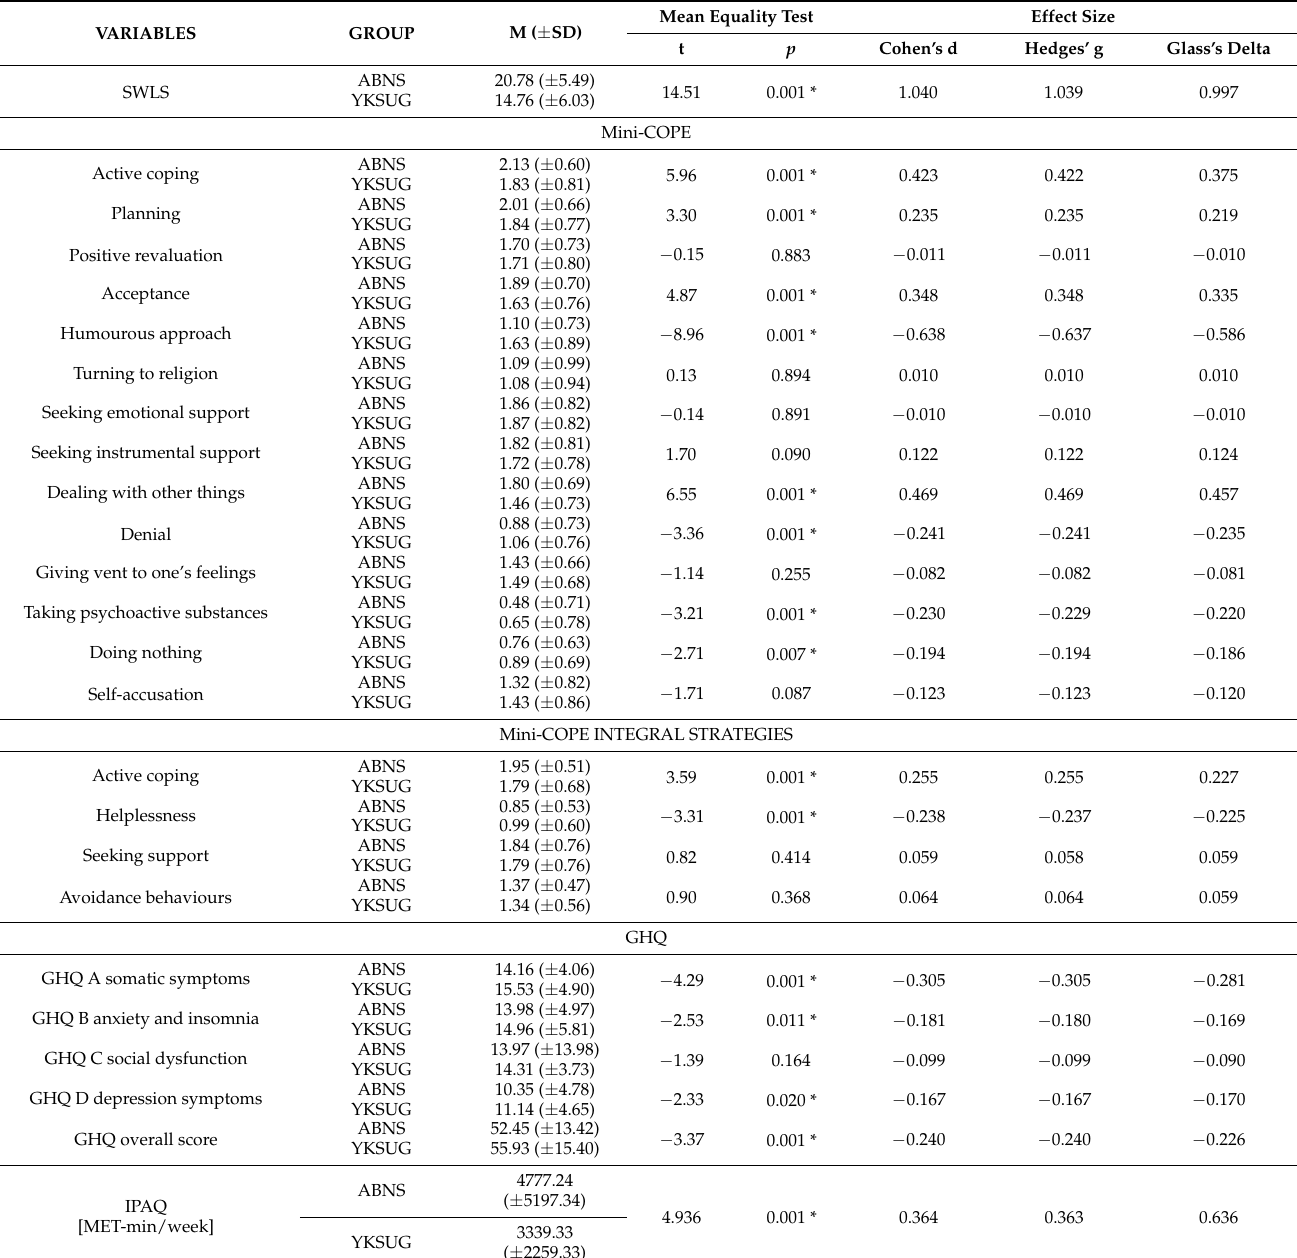
Table 4. Differences in test results between groups ABNS and